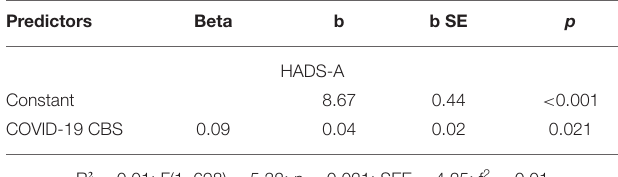
TABLE 5 | Regression model of anxiety and depression symptoms severity in the light of belief in false information about the COVID-19 pandemic ( N = 700 and N =